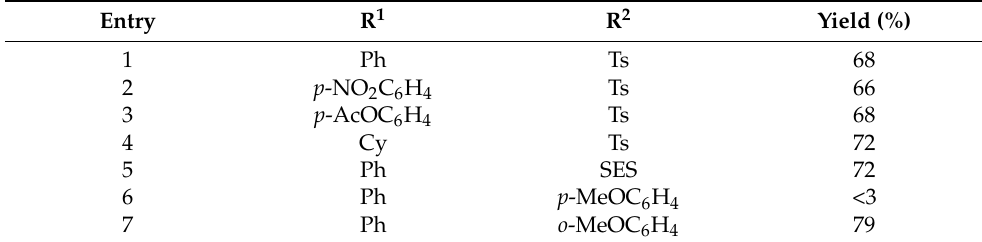
Table 8. Scope of Simmons–Smith carbenoid aziridine synthesis (Scheme 29).